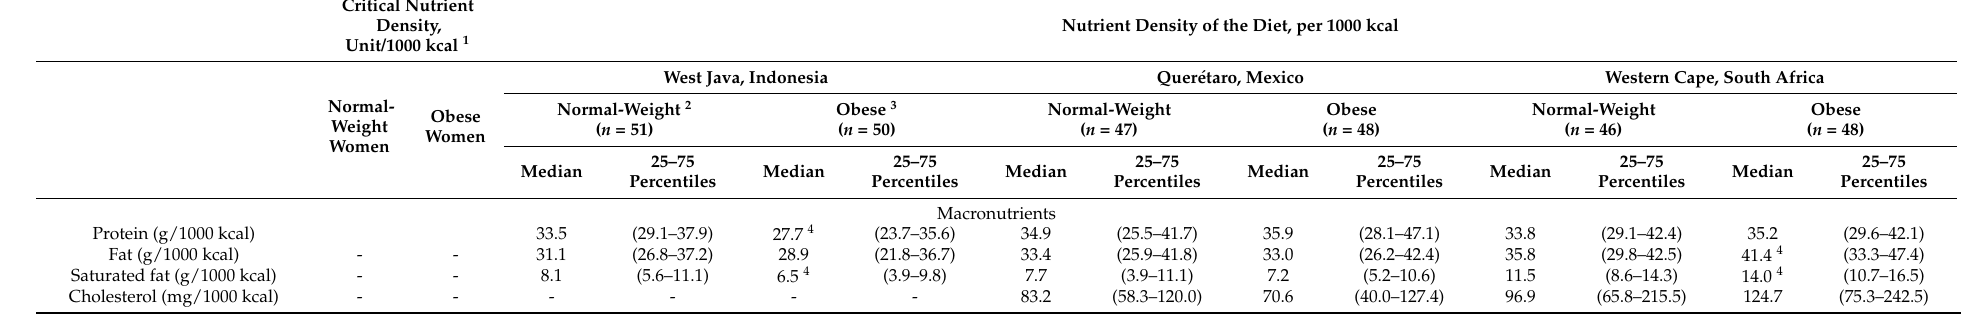
Table 4. Median density of the diet based on a single 24 h dietary recall by survey area for normal-weight vs. obese women. Critical Nutrient